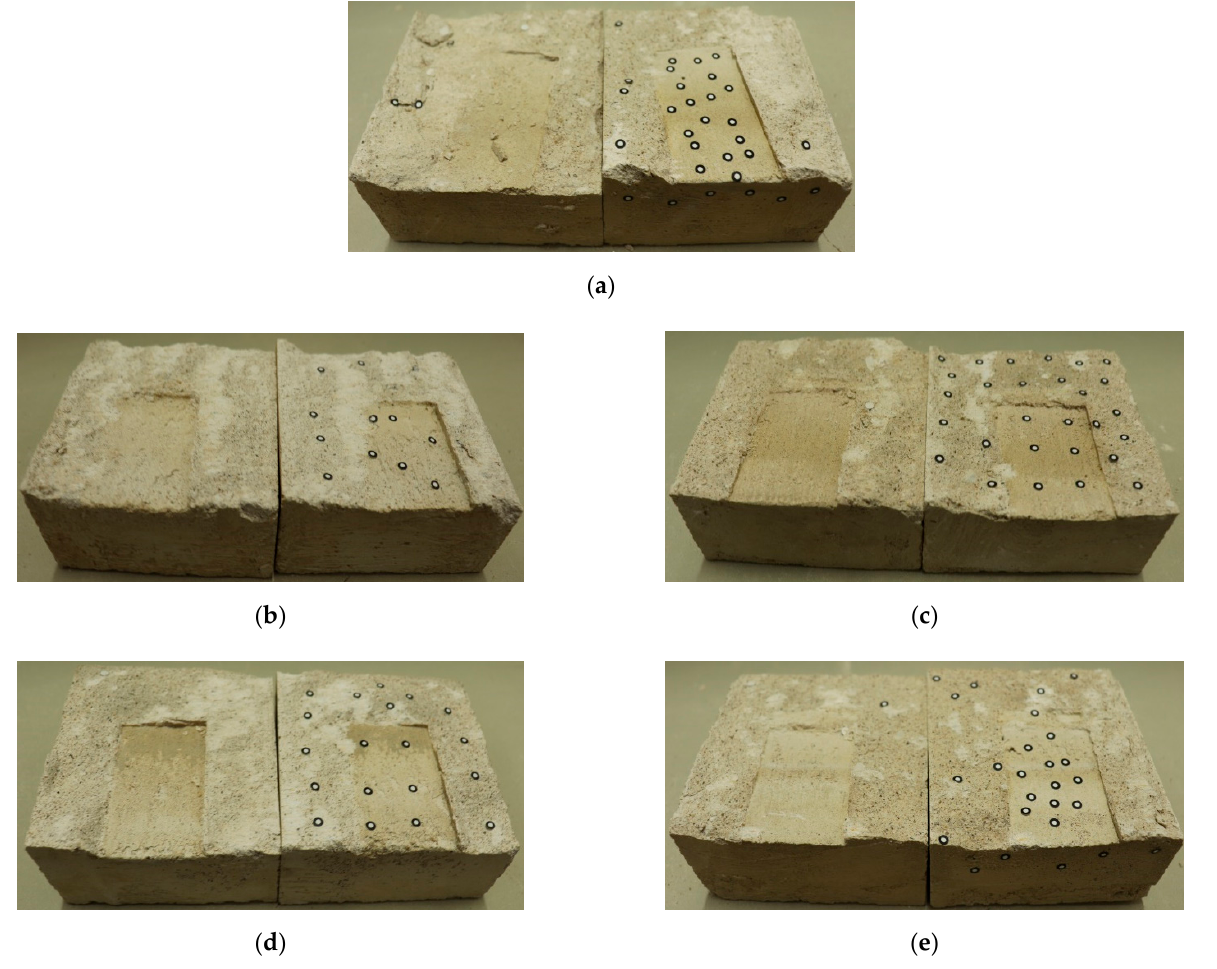
Figure 8. Shear surface under freeze-thaw cycles after the second shear test. ( a ) Zero freeze-thaw cycles. ( b ) Ten freeze-thaw cycles. ( c ) Twenty freeze-thaw cycles. ( d ) Thirty freeze-thaw cycles. ( e ) Forty freeze-thaw cycles.